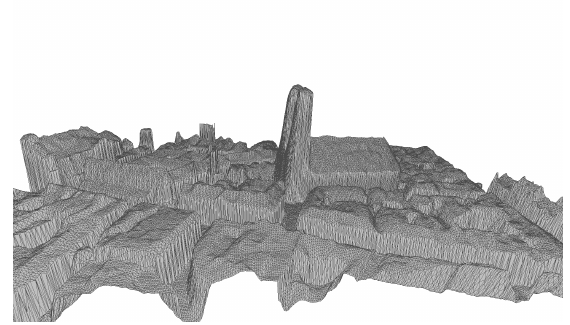
Figure 6. Triangulated digital surface model.